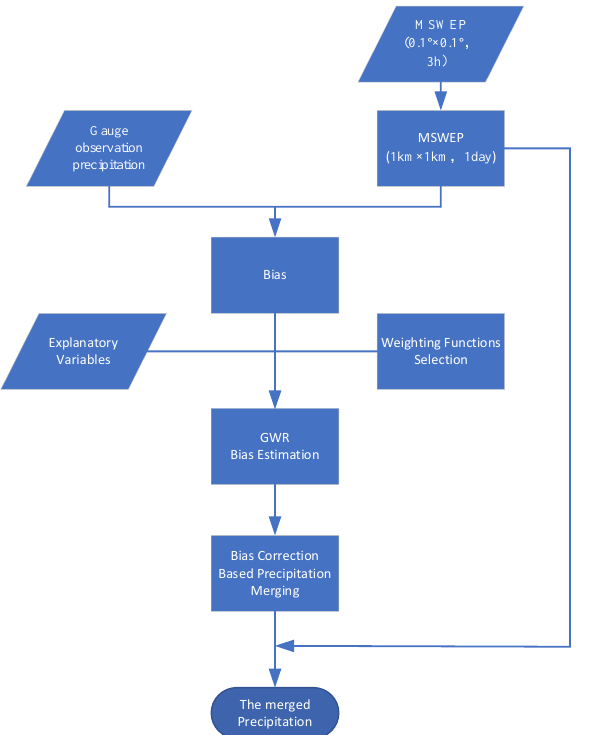
Figure 4. Flowchart of the GWR-based two-step merging scheme proposed in this study.